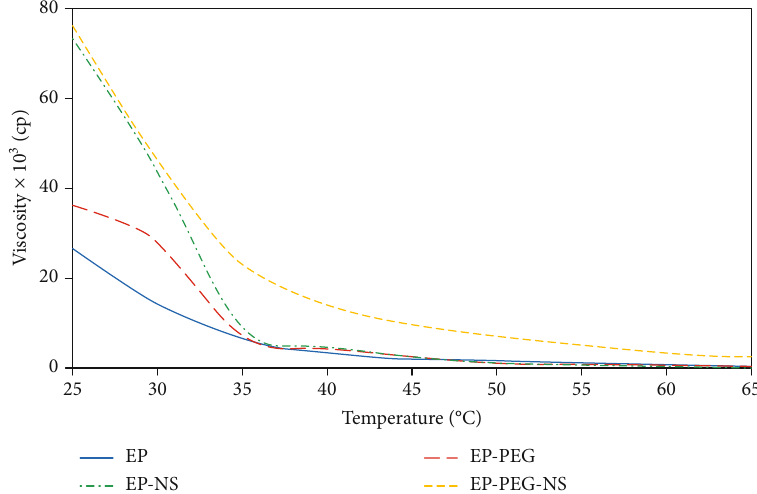
Figure 4: Viscosity-temperature diagrams of di ff erent samples.